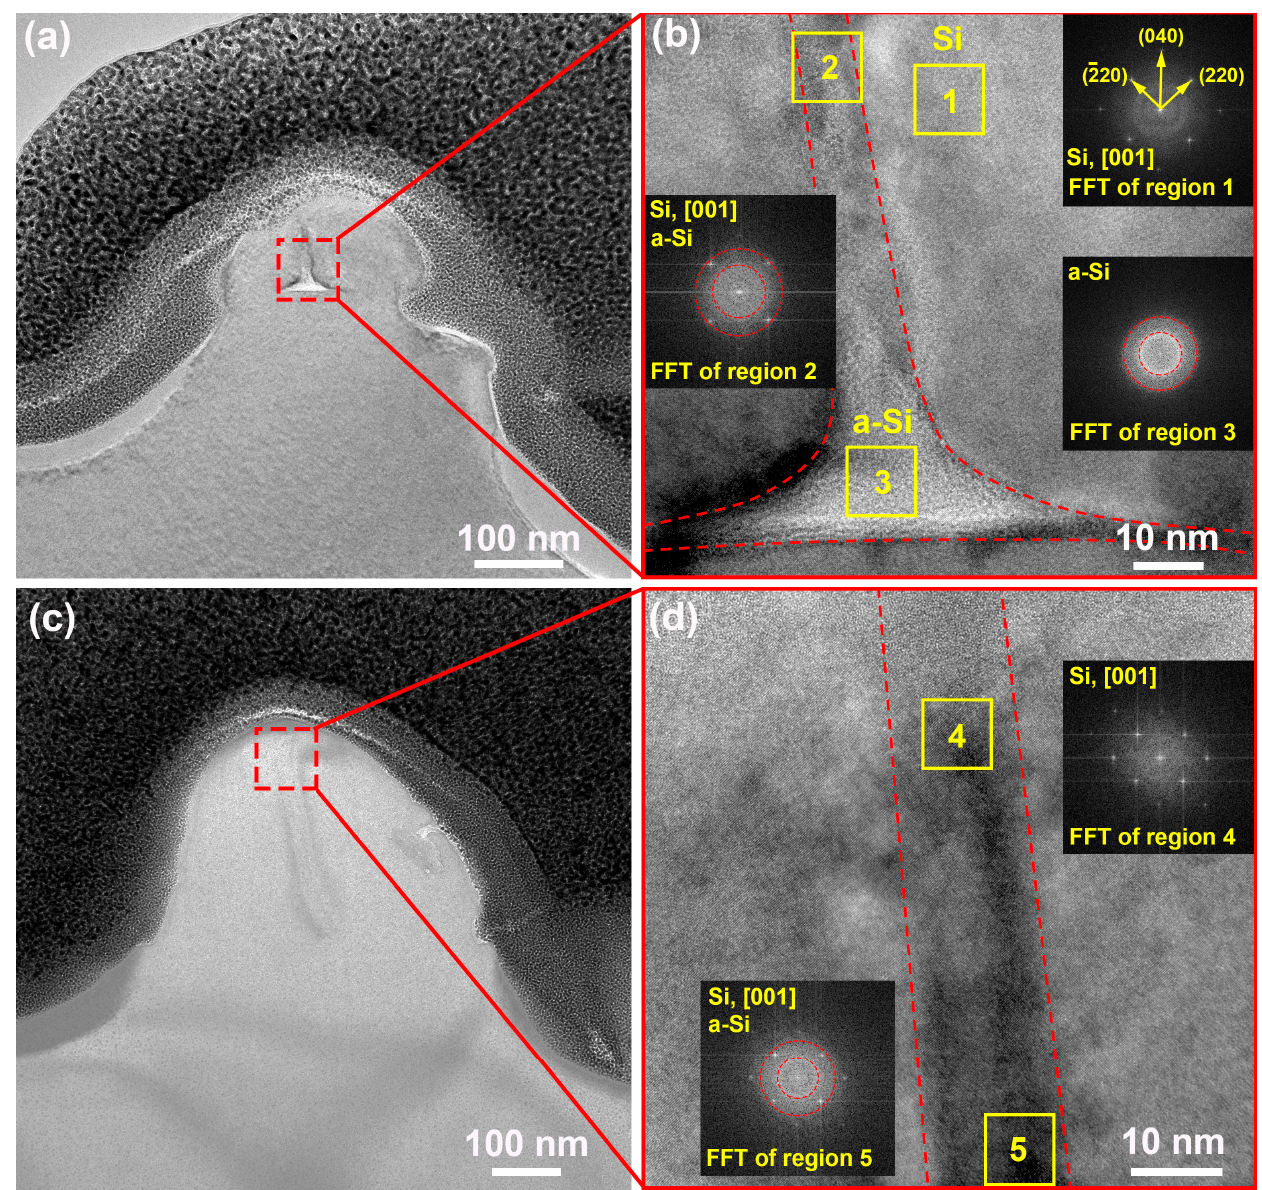
Figure 7. ( a ) Bright-field image of the purple dashed square 1 in Figure 5a; ( b ) HRTEM image of the red dashed square in ( a ); ( c ) bright-field image of the purple dashed square 2 in Figure 5a; ( d ) HRTEM image of the red dashed square in ( c ).